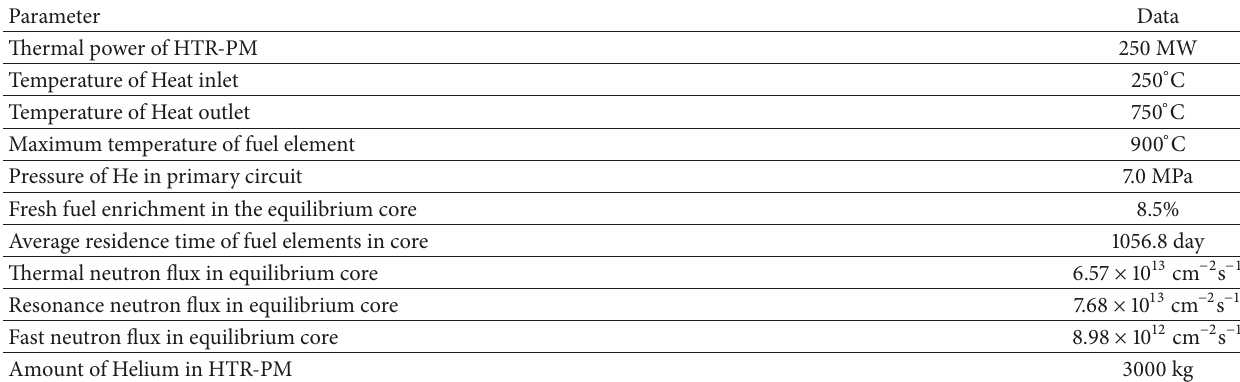
Table 1: Design parameters of HTR-PM.